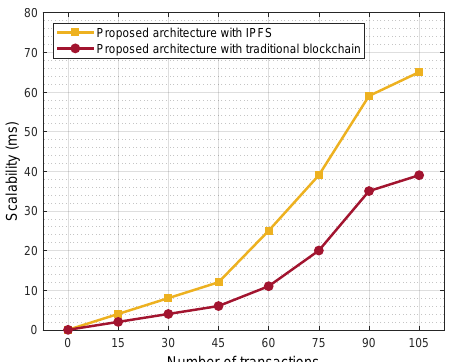
Figure 9. Evaluation of the scalability comparison of the blockchain